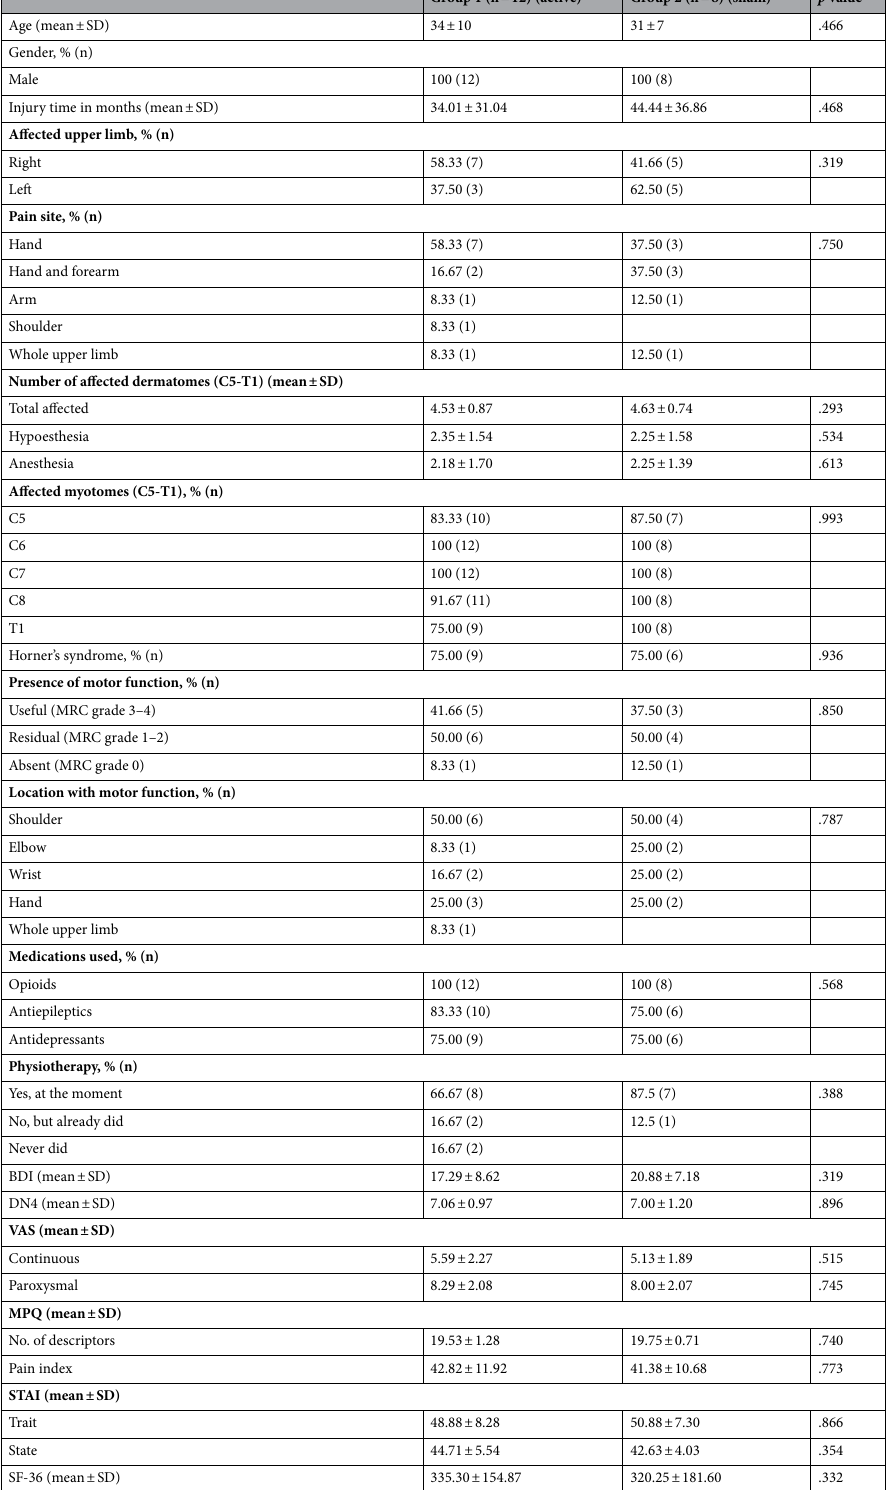
Table 1. Demographic and clinical data at baseline (intent-to-treat population). Clinical and sociodemographic characteristics at baseline did not differ between the groups.BDI Beck Depression Inventory, DN4 DN4 questionnaire, VAS Visual Analogic Scale, MPQ McGill Pain Questionnaire, STAI State- Trait Anxiety Inventory, SF-36 SF-36 Quality of Life Questionnaire, MRC Medical Research